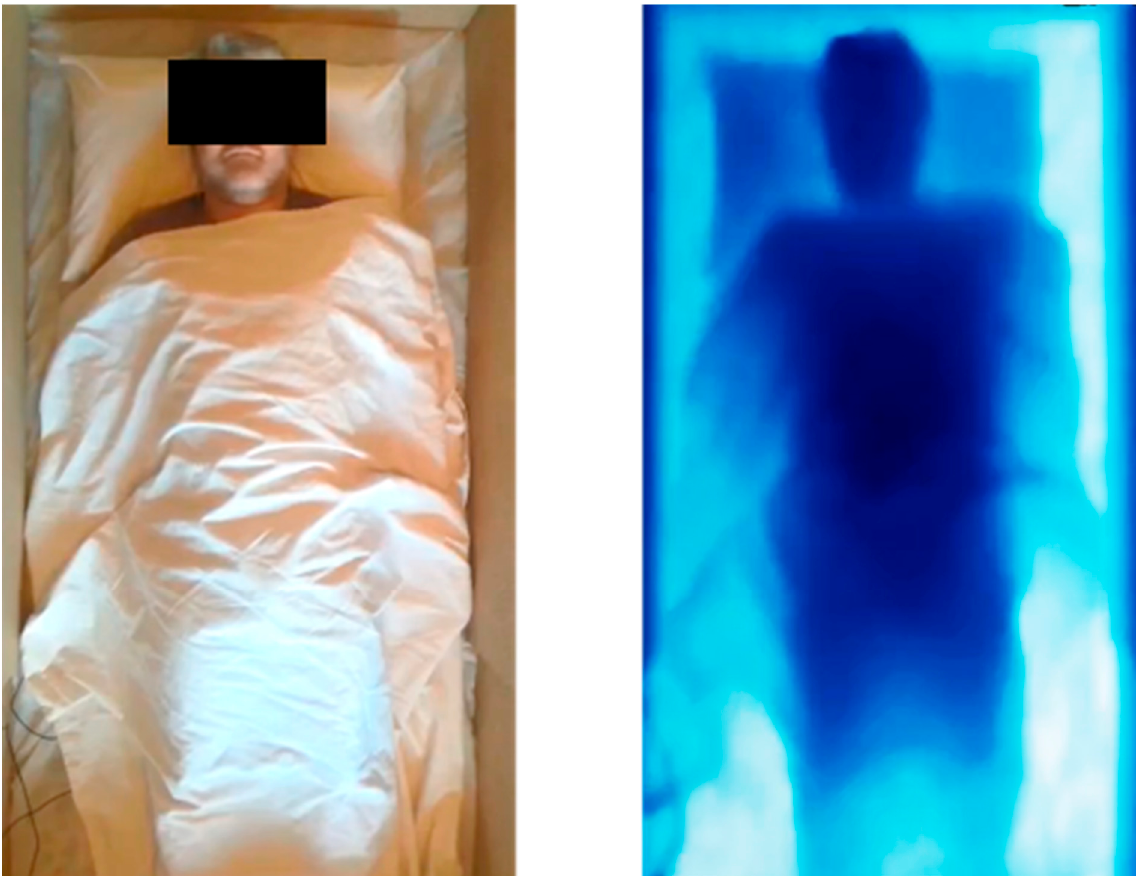
Figure 1. An RGB image of a subject under a sheet (left) and its corresponding depth image (right).